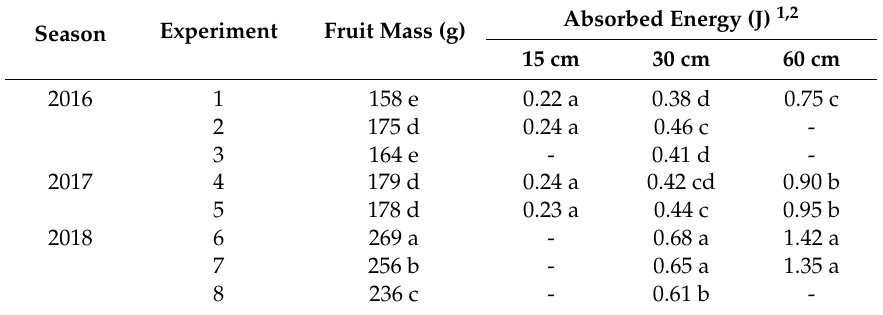
Figure 2. Relationship between fruit mass and energy absorbed by unripe ‘Hass’ avocado fruit upon impact from drop heights of 15 ( ), 30 ( ) or 60 ( ) cm. Data points represent individual fruit values obtained from eight experiments. Dotted lines represent linear regression equations for 15 cm (absorbed energy = -0.01147 + 0.001382 fruit mass; R 2 = 0.75; p < 0.001; n = 140), 30 cm (absorbed energy = -0.03181 + 0.002645 fruit mass; R 2 = 0.96; p < 0.001; n = 300) and 60 cm (absorbed energy = -0.1290 + 0.005716 fruit mass; R 2 = 0.97; p < 0.001; n = 190) drop heights. Table 2. Between-experiment comparison of fruit mass and energy absorbed by fruit upon impact from drop heights of 15, 30 and 60 cm.